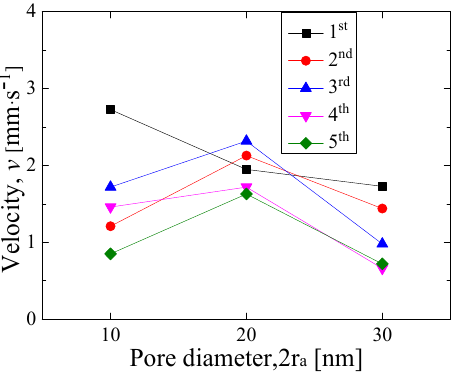
Figure 9. Experimental values of the operating speed of 10-2 r a C18 silica gel CDs.